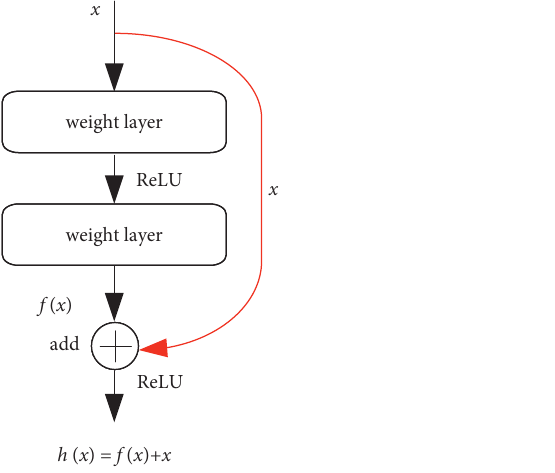
Figure 3: Structure of the residual